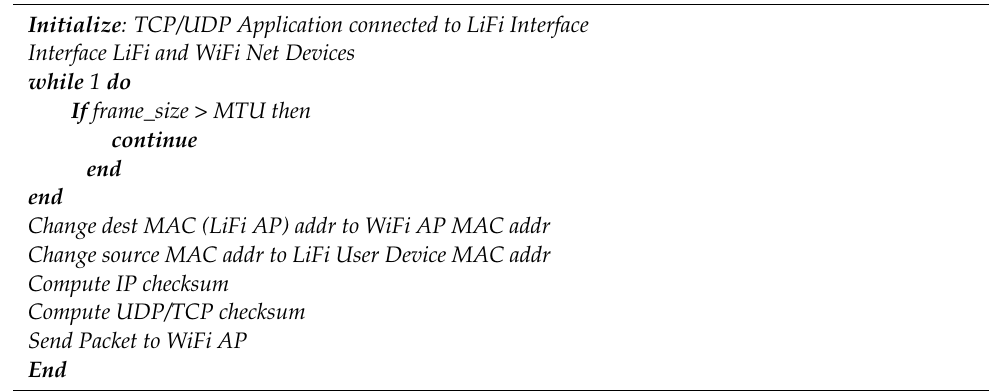
Algorithm 2: Asymmetric TCP/UDP